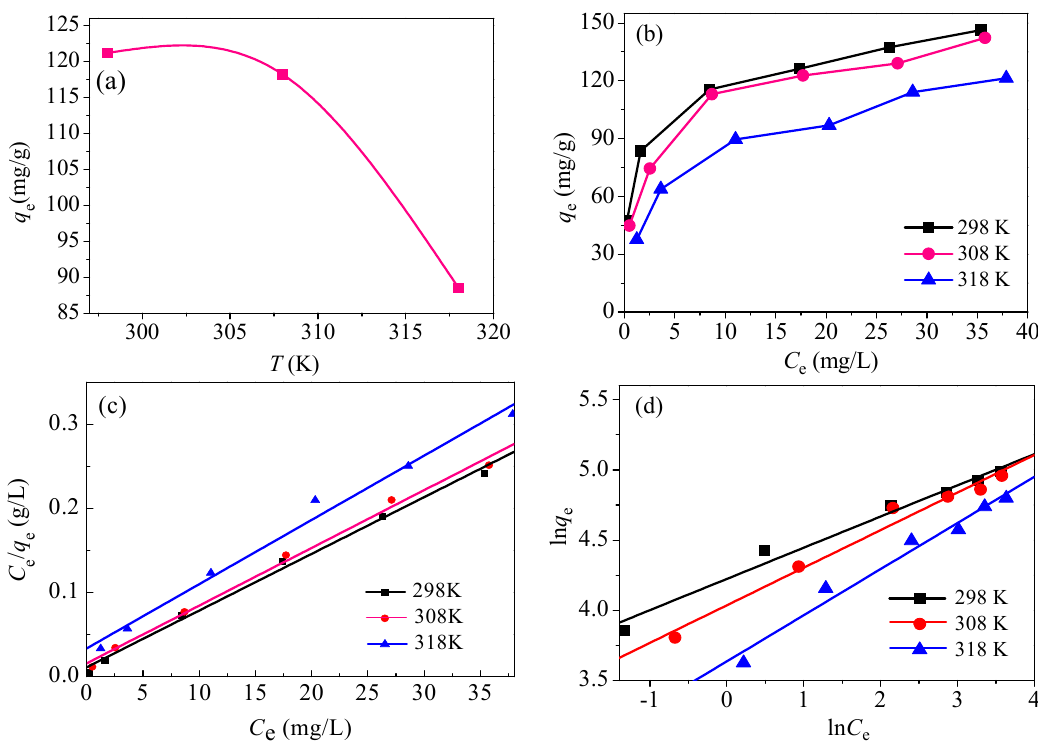
Figure 13. ( a ) Effect of temperature on adsorption; ( b ) adsorption isotherms of Hg(II) onto CoFe 2 O 4 @SiO 2 -NH 2 ; ( c ) Langmuir; ( d ) and Freundlich isotherm curves.